Question: What style of plot is this figure drawn as?
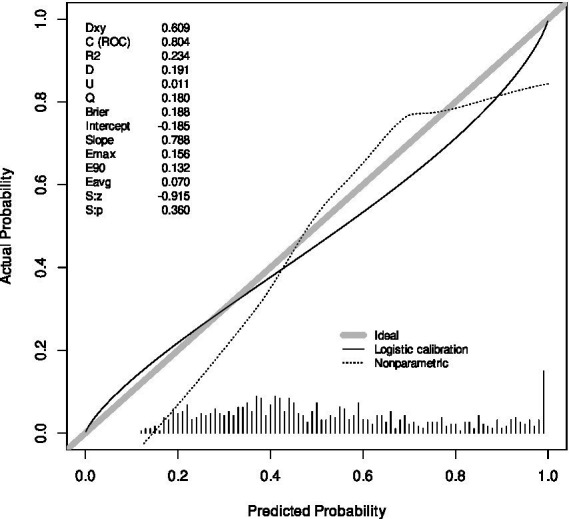
Answer: line